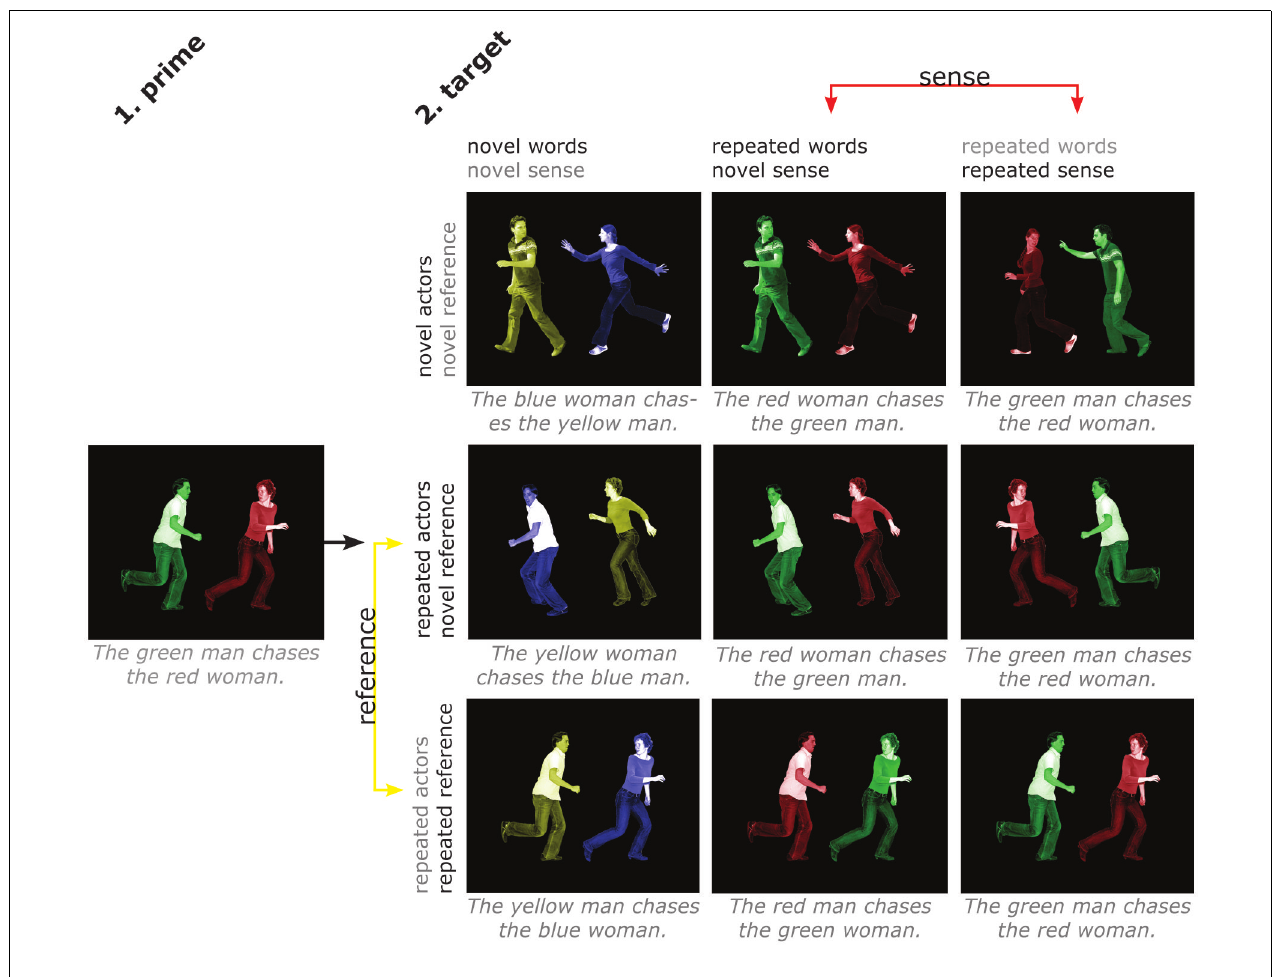
crossed, since it is not possible to repeat sense without, at least partly, repeating words, as it is not possible to repeat a situation while changing the people involved.Therefore, each of the factors varies only at one level of the factor it could potentially be confounded with.The contrasts of interest are between the middle and right column for sense (hence keeping repetition of words controlled) and between the middle and bottom row for reference (hence keeping repetition of actors controlled). Likewise, the effect of word repetition was computed by comparing the leftmost and middle column, and the effect of actor repetition by comparing the top and middle